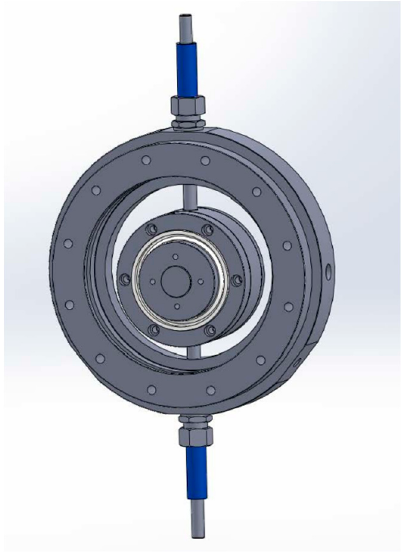
Figure 4. Bearing joint connecting two sections of inner pipe.